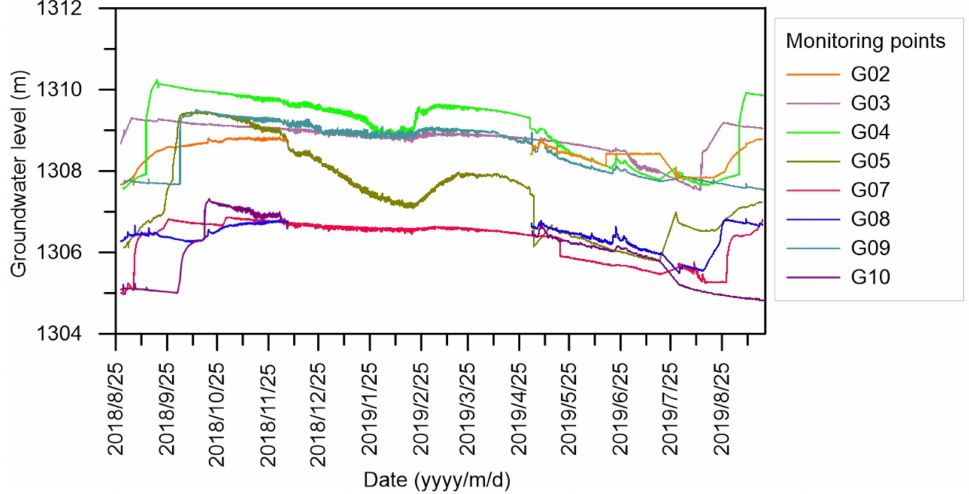
Figure 5. Groundwater-level hydrographs at various monitoring points in the Qingtu Lake wetland area from 2018 to 2019.